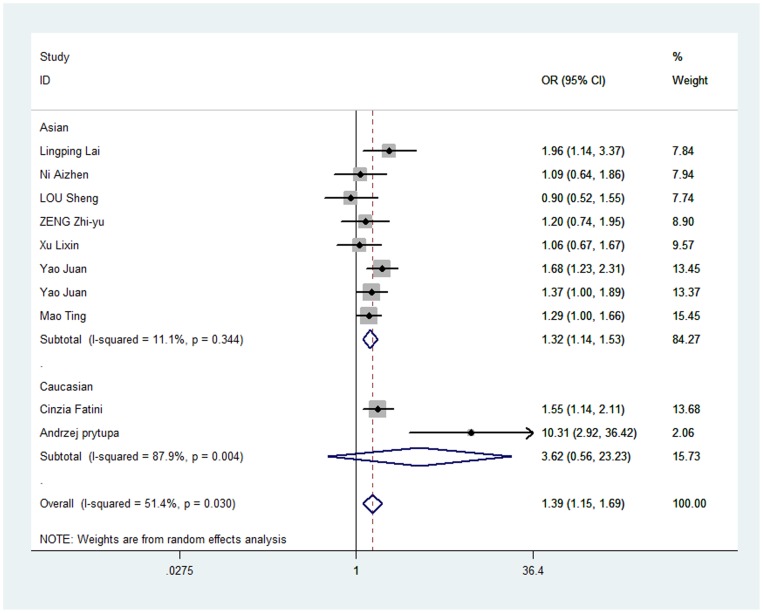
Forest plot of recessive model (GG vs. GA/AA) for overall comparison in random-effects model.(OR = 1.394, 95%CI: 1.152, 1.686; Pheterogeneity = 0.03).